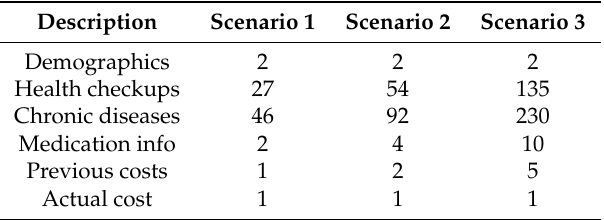
Table 5. Number of variables by type in patient